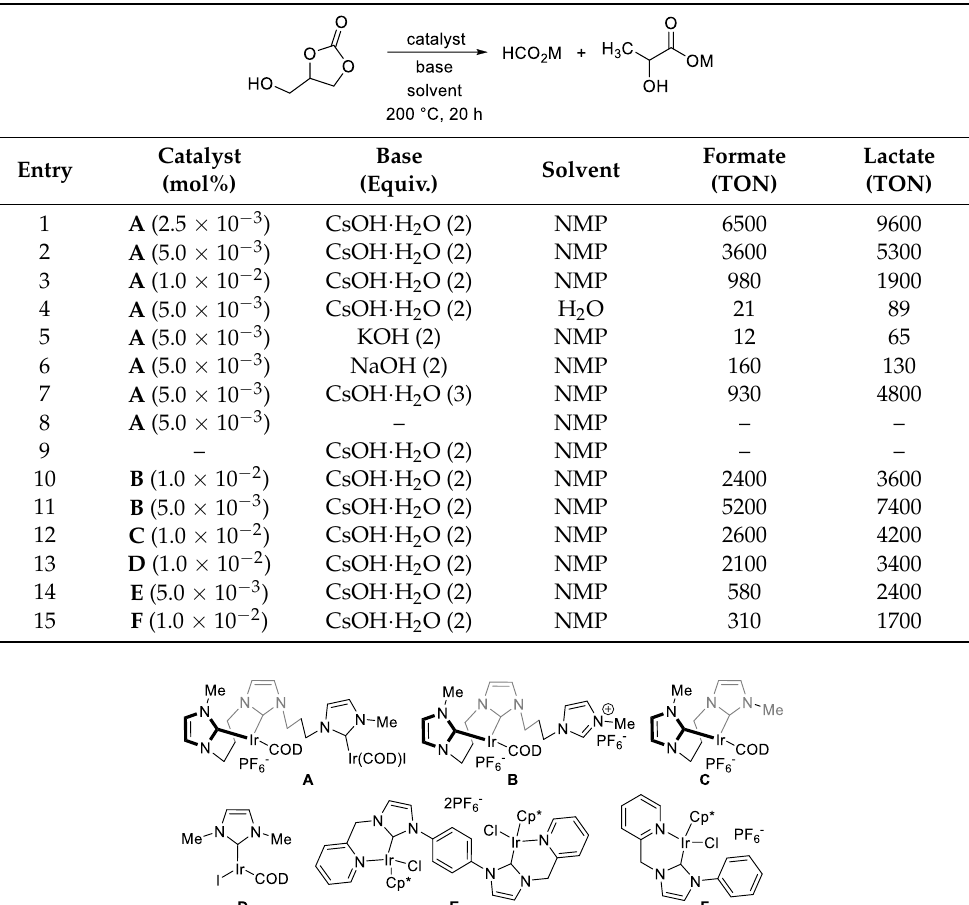
Table 1. Transfer hydrogenation of GC.